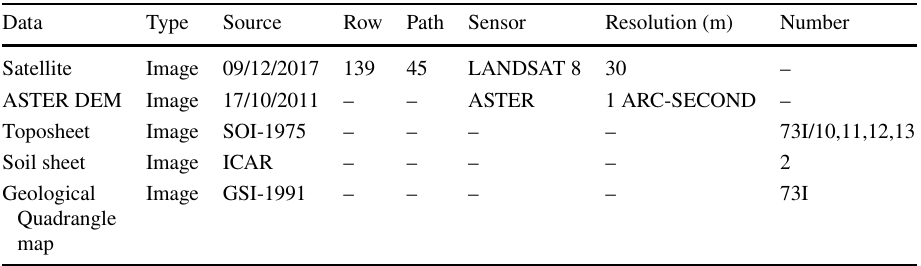
Fig. 2 Methodological flow chart of basin prioritization of morphometric, geology, geomorphology, LULC, slope and